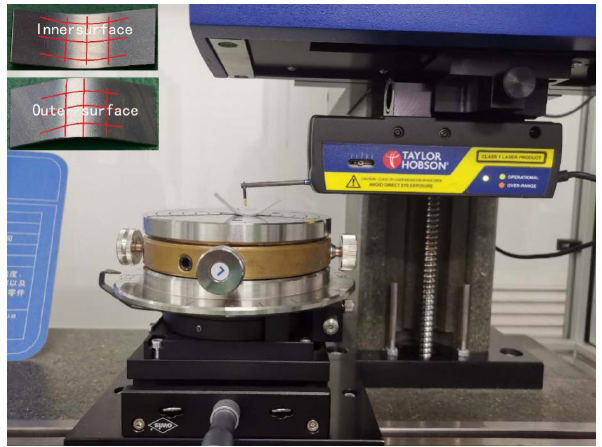
Figure 19. Surface roughness measurement by the 3D surface pro- filing instrument.